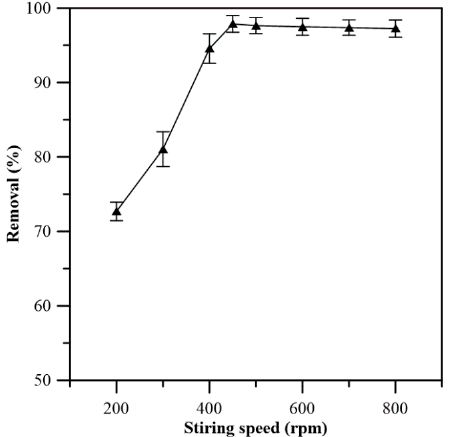
Figure 5. Influence of the stirring speed on the removal rate. Feeding solution: [Cr(VI)] = 53 mg/L at pH 4; stripping phase: NaOH solution at pH